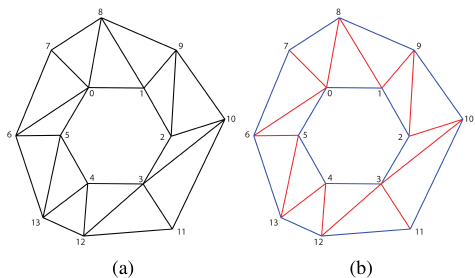
Figure 9: Example of a 2D point cloud with points connected by Delauney triangular meshes.